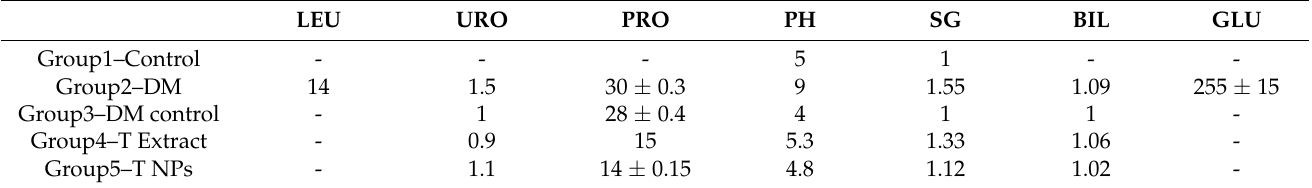
Table 2. Effect of methanolic extract and synthesized T. couneifolia AgNPs on urine analysis.